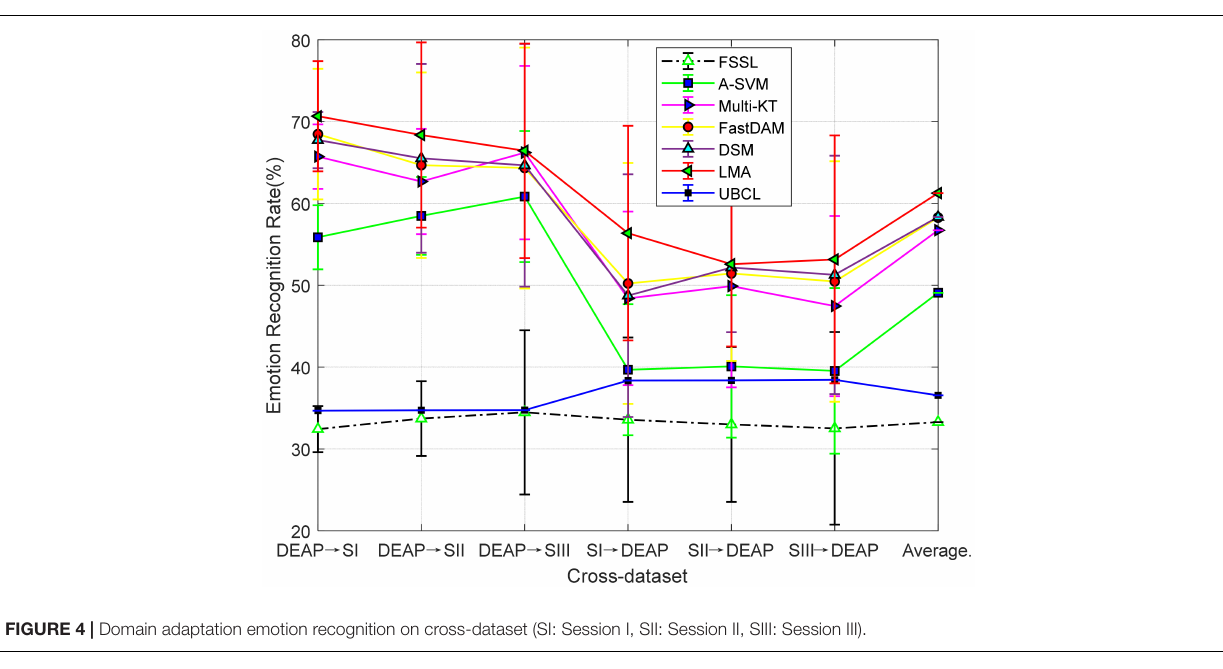
FIGURE 3 | Domain adaptation emotion recognition on within-dataset with multi-kernel learning (SI: Session I, SII: Session II, SIII: Session III).